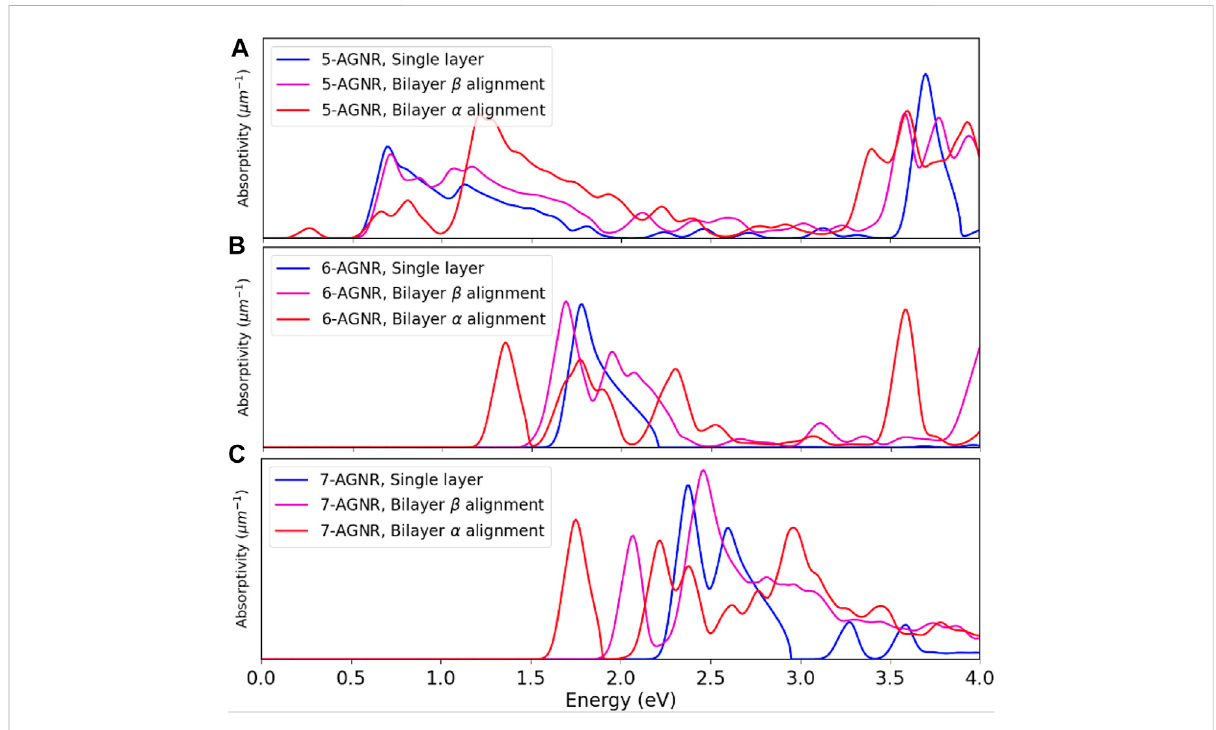
FIGURE 11 Comparison of absorptivities of single layer, bilayer α and bilayer β armchair graphene nanoribbons. (A) Absorptivities of 5-AGNR. (B) Absorptivities of 6-AGNR. (C) Absorptivities of 7-AGNR.